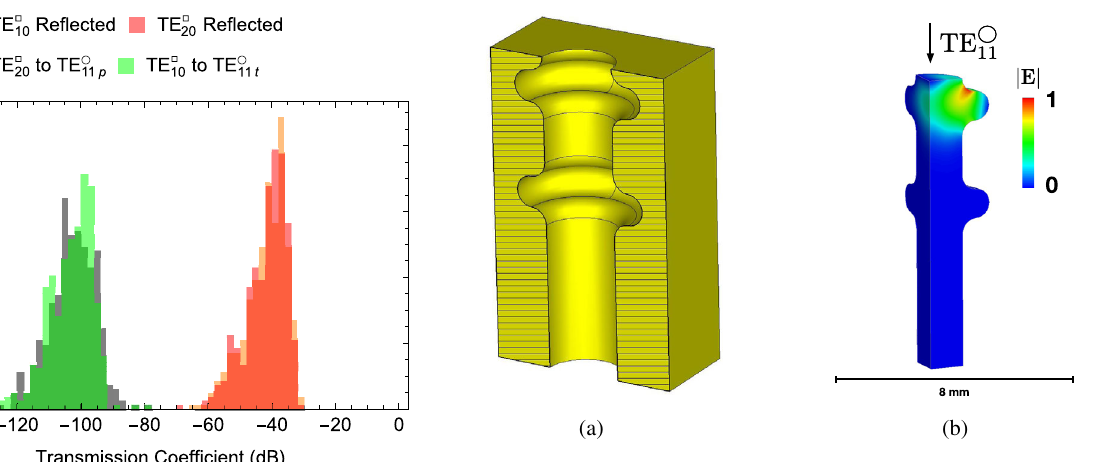
FIG. 20. TE ○ 11 double choke. (a) Metallic surface and (b) surface electric